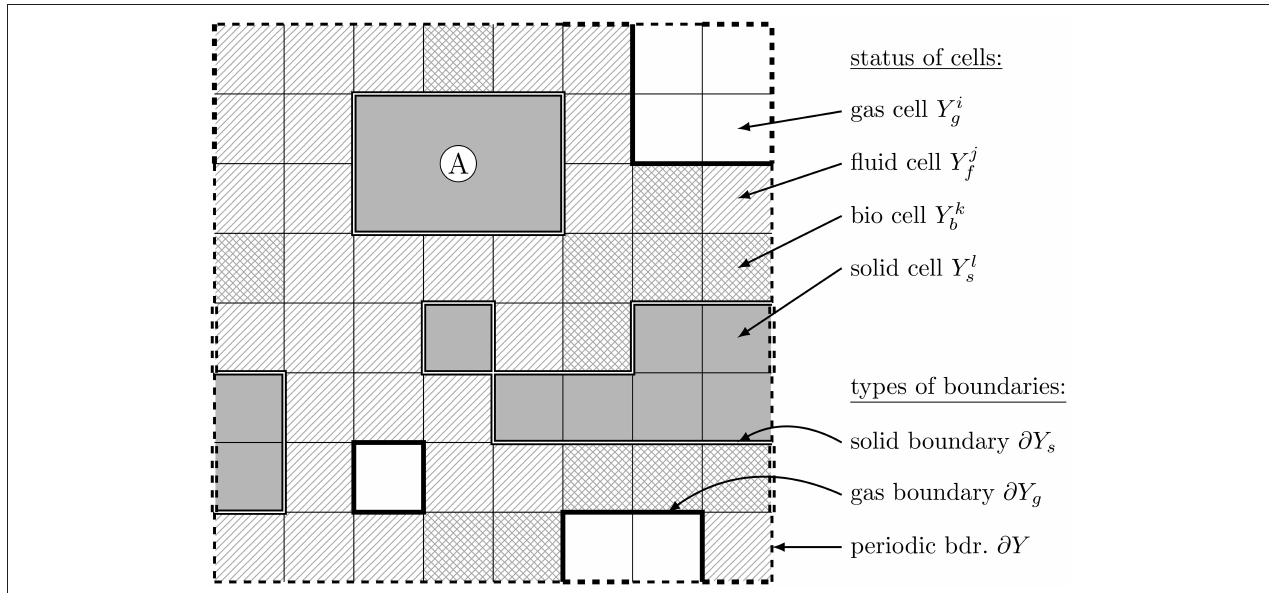
FIGURE 1 | Domain Y , geometric structure, cell states—gas ( ), fluid ( ), bio ( ), solid ( )—and prototypic representation of an inseparable building unit A .